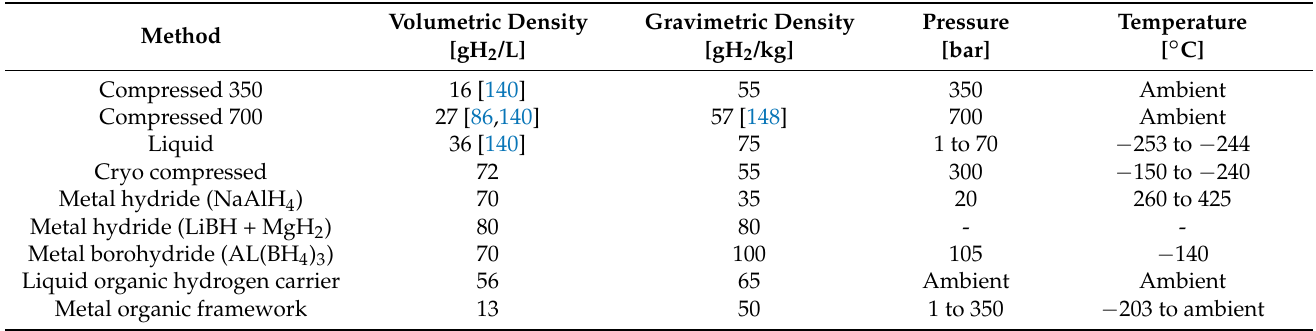
Table 2. Comparison of various H 2 fuel onboard storage techniques for long-haul heavy-duty road mobility